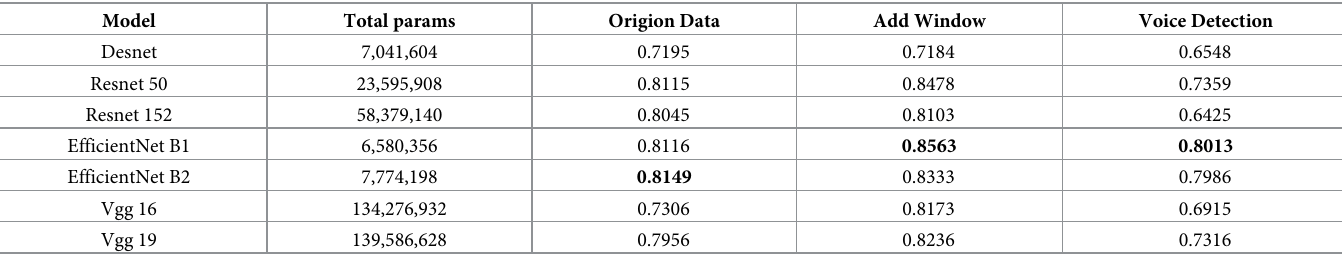
Table 2. Database audio volume classification